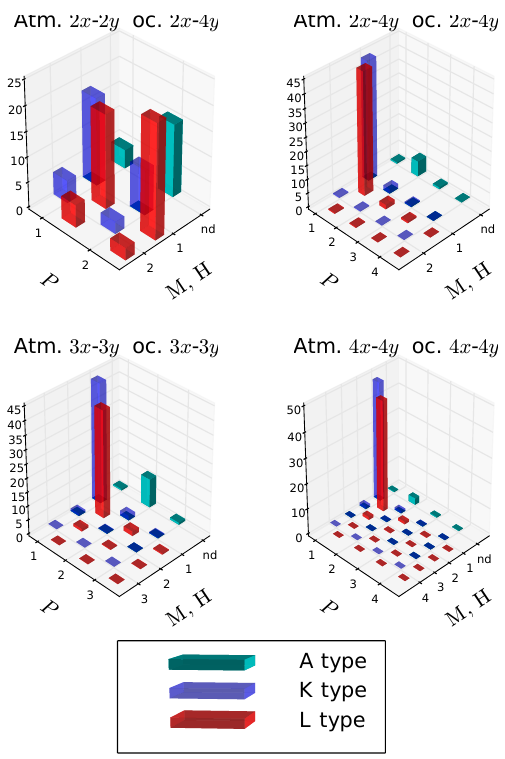
Figure 4. Variance distributions of the ψ a ,i variables in percents for various model resolutions (continued from Fig. 3). For the variables associated with the A -type basis functions, the wave numbers M and H are not defined